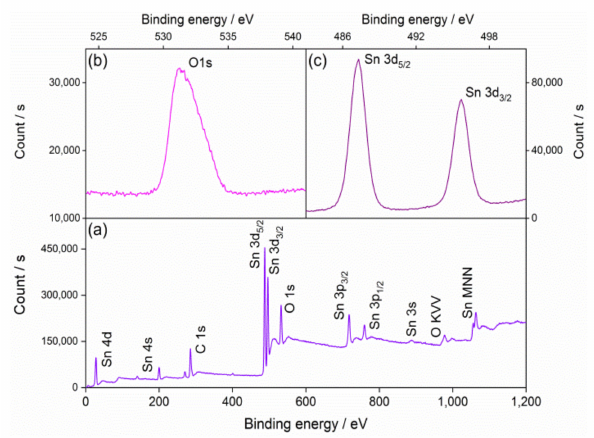
Figure 4. X-ray photoelectron spectrum of the QD0 sample: ( a ) Survey and high-solution peaks of ( b ) O 1s and ( c ) Sn 3d.